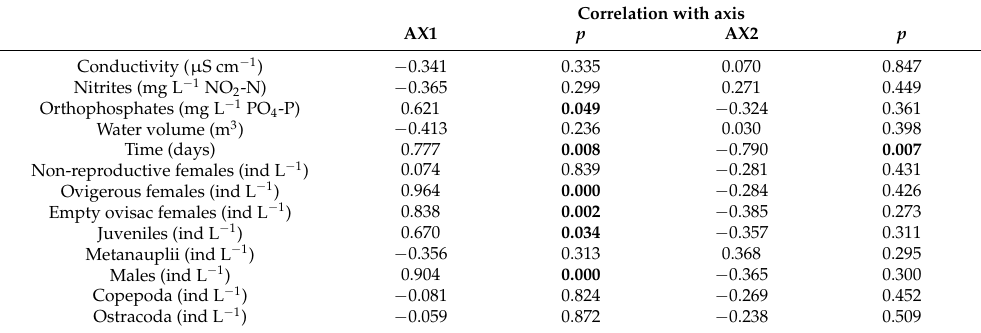
Table 2. Canonical and correlation coefficients of biological and environmental variables with axis. p < 0.05 is in bold.